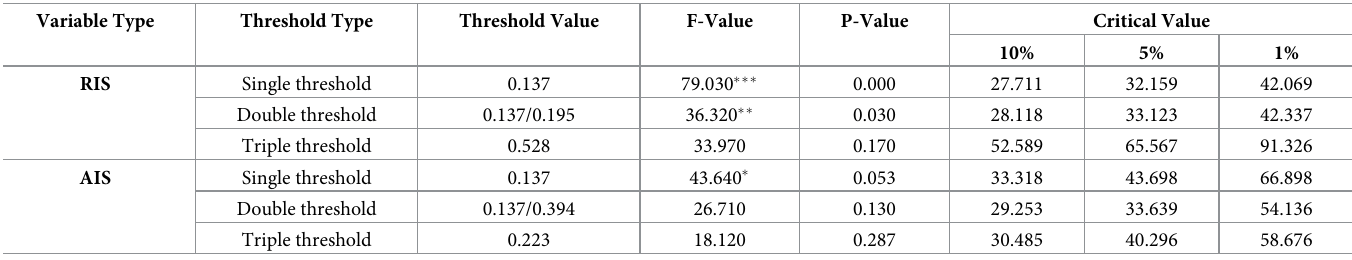
Table 14. Threshold value estimation